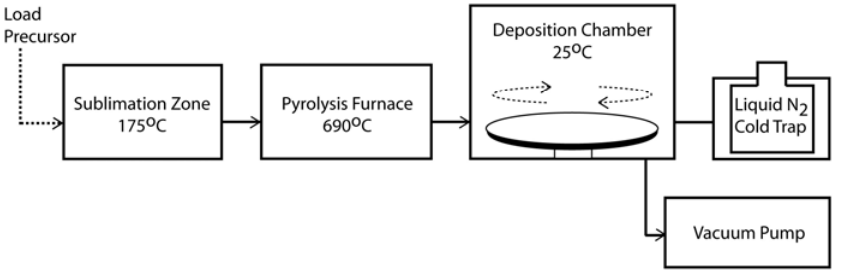
Figure 1. CVD polymerisation of parylene-C. The precursor is loaded into the sublimation zone (175 °C). The sublimed form of the precursor is transported into the furnace (690 °C) for pyrolysis into the reactive monomer, which finally polymerises into parylene spontaneously upon cooling in the deposition chamber (25 °C). The substrate stage is usually rotated for increasing the uniformity of